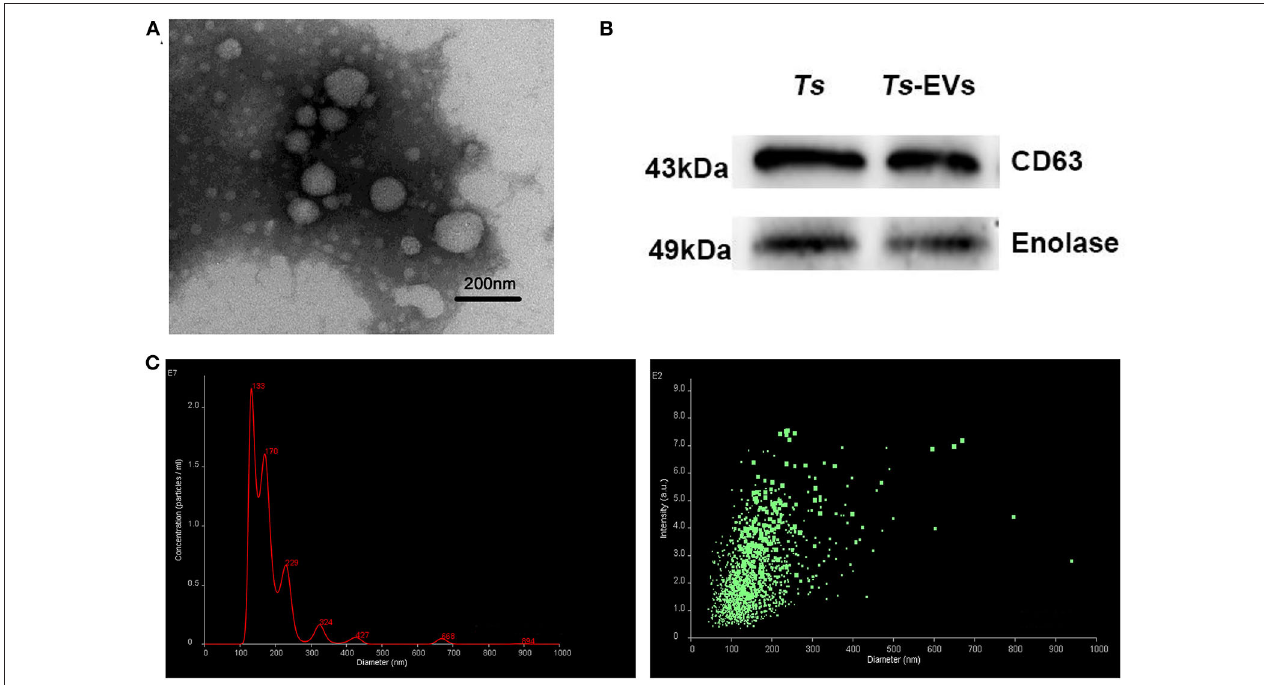
FIGURE 1 | Characterization of T. spiralis muscle larvae extracellular vesicles ( Ts -EVs). (A) Ts -EVs ultrastructure was visualized by negative-staining TEM (magnification 40,000 × ; scale-bars = 200nm). (B) Expression of Ts -EVs-specific markers CD63 and enolase was determined by Western blotting. (C) Size distribution profile of Ts -EVs was investigated using NTA. TEM: Transmission electron microscopy; NTA: Nano tracking analysis.